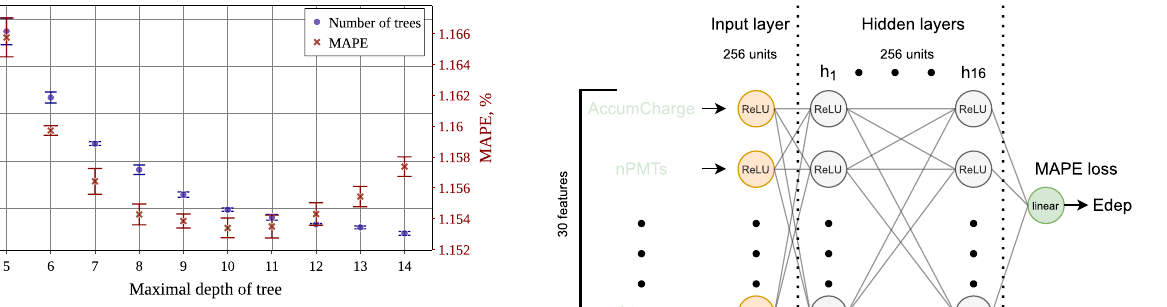
Fig. 11 Dependence of the minimal optimum number of trees and the corresponding MAPE score for the validation dataset on the maximum depth of a tree Fig. 12 Selected FCDNN architecture and its main selected hyperpa-